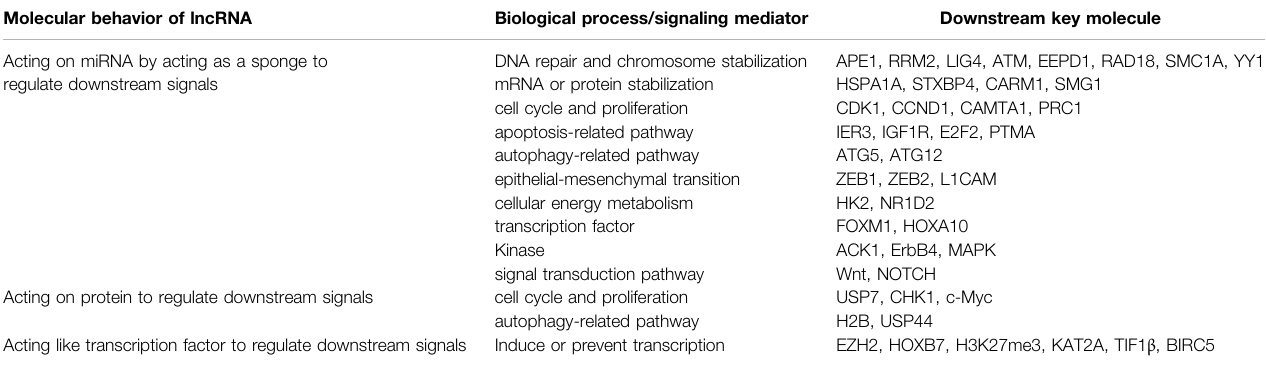
TABLE 1 | The summary of mechanisms by which lncRNAs contribute to cancer radioresistance/radiosensitivity. Molecular behavior of